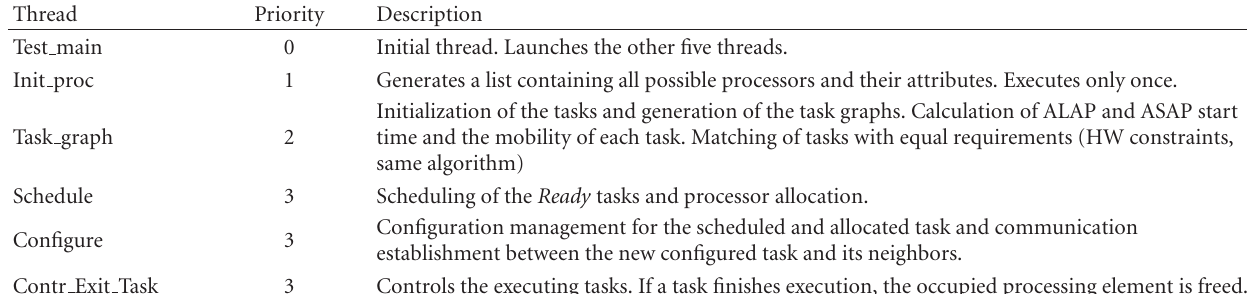
Figure 10: Implemented RAMPSoC system. Table 4: Realized threads of the CAP-OS.